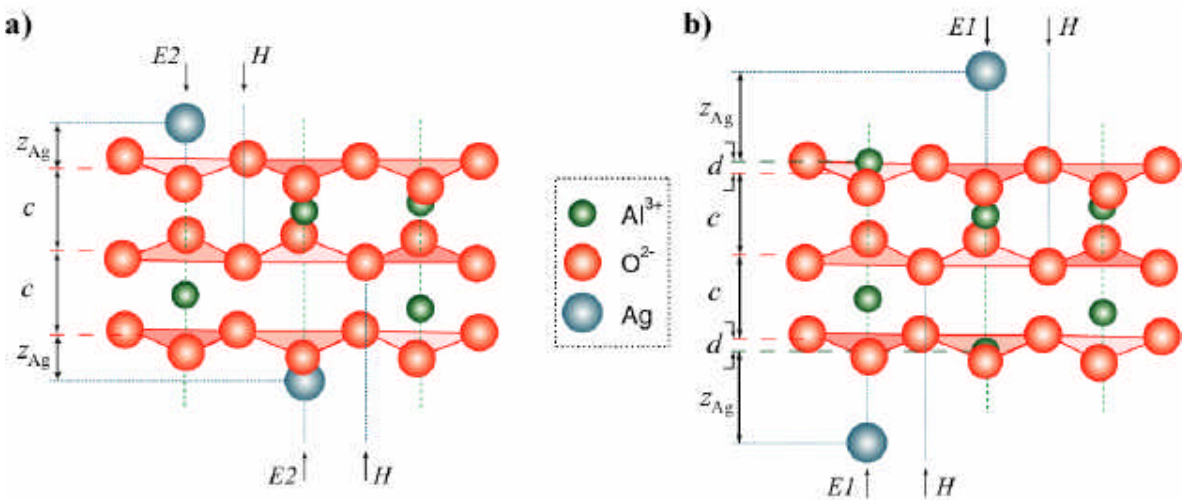
Figure 2 . Side views of a -Al O (0001) slabs where silver atoms at 1/3 ML coverage are distributed 2 3 regularly on the aluminium C axes above and below O-terminated (a) and Al-terminated (b) models, 3v respectively. The interlayer structure of the interface is defined by c , d and z probable positions for Ag adsorption have been found to be E1 for (b), E2 for (a), and H